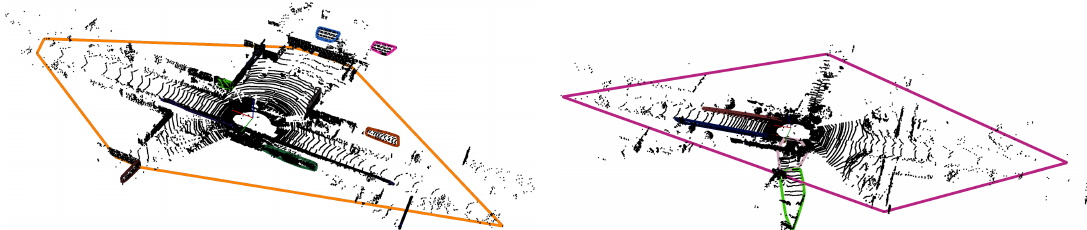
Figure 4. Two different examples showing how to select a coplanar base. First, several objects in the scene are clustered, after which they are subjected to a plane-fitting algorithm. In case a few planes have been detected, their convex hulls are computed. A coplanar base is then selected by picking four points close to the convex